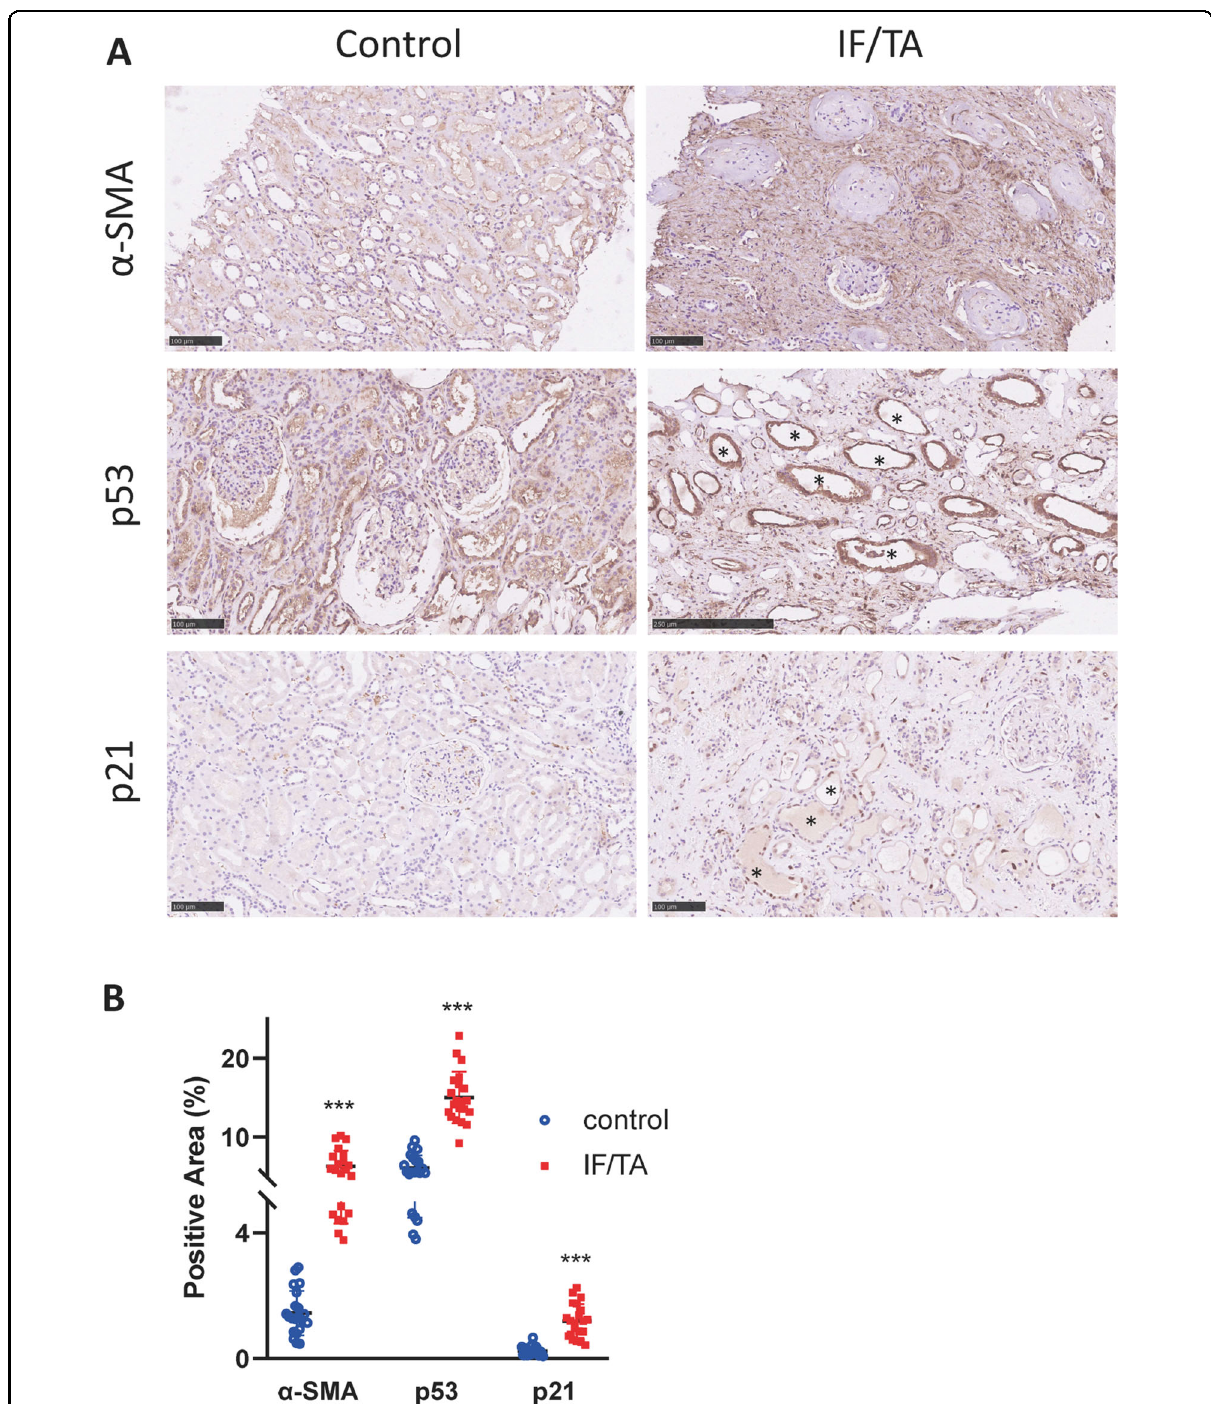
Fig. 1 α -SMA and p53 – p21 axis are upregulated in kidney allograft with chronic rejection. A Immunohistochemistry staining of α -SMA, p53, and p21 in allograft kidneys and B their quanti fi cations. Three random fi elds were chosen in each sample. Scale bar = 100 μ m. *** P <